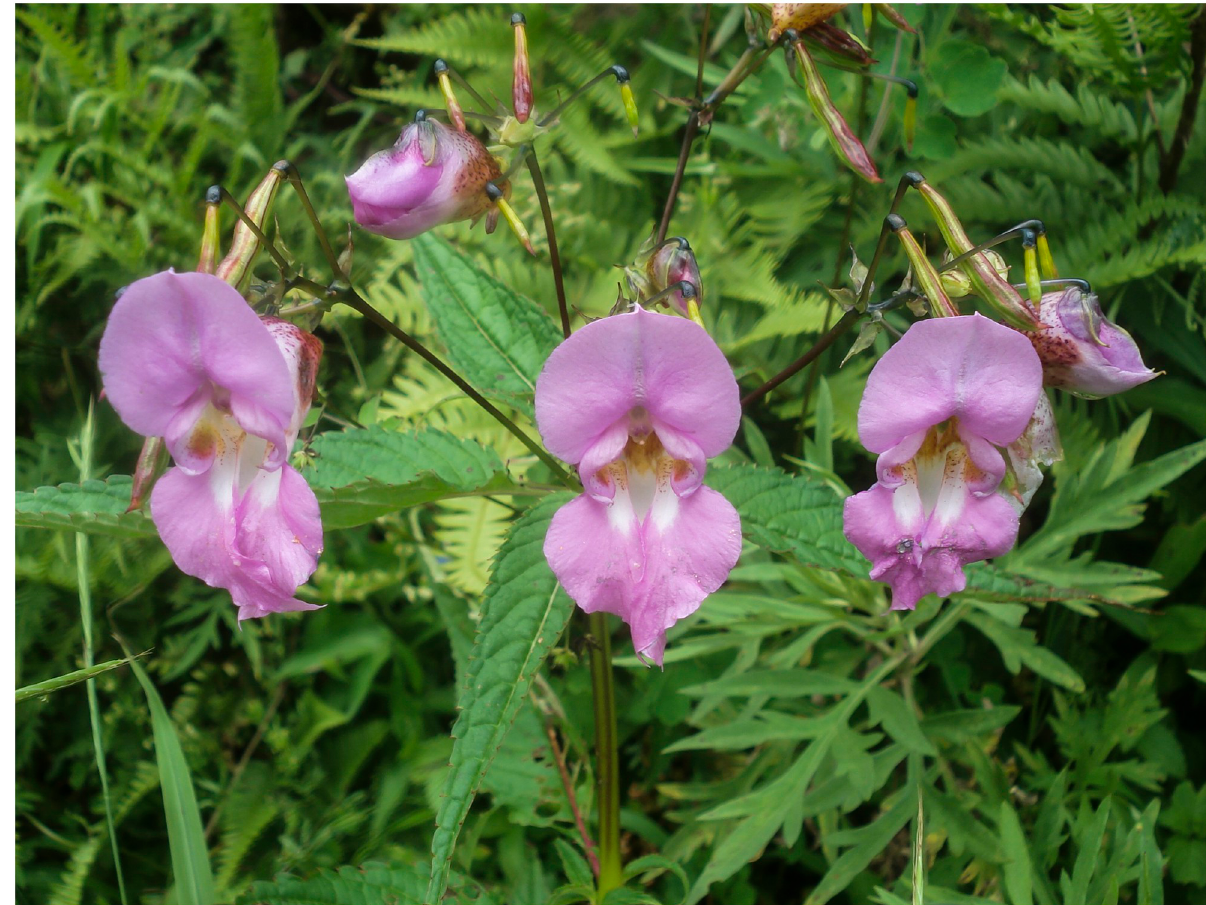
Fig 13. Impatiens glandulifera (flowering plant). Photograph by Bhakta Bahadur